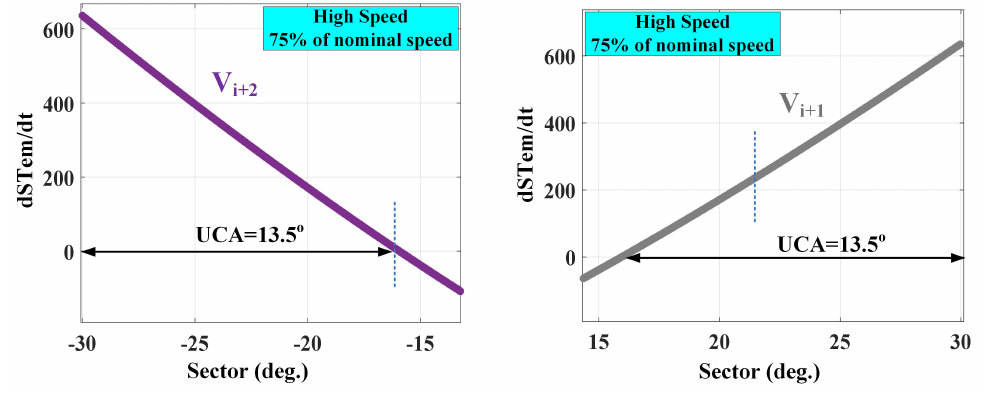
Figure 6. UCA of V i + 2 or V i + 1 on dS Tem for high speed ( 75% ω n )